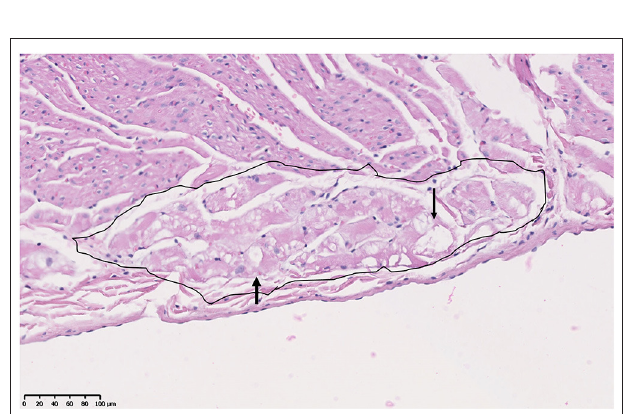
FIGURE 5 | Purkinje fiber (circled area) vacuolation (clear spaces indicated by arrowheads) in the heart of an 18-month-old male Golden Retriever muscular dystrophy dog. H&E, × 20